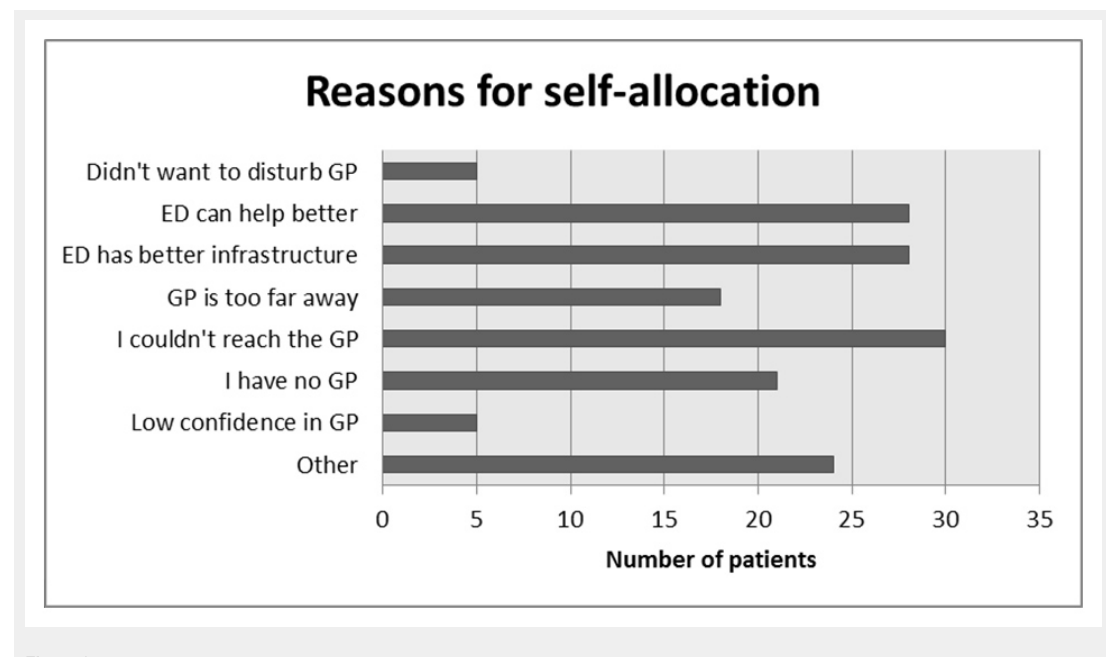
Why did I choose to visit a hospital ED instead of a